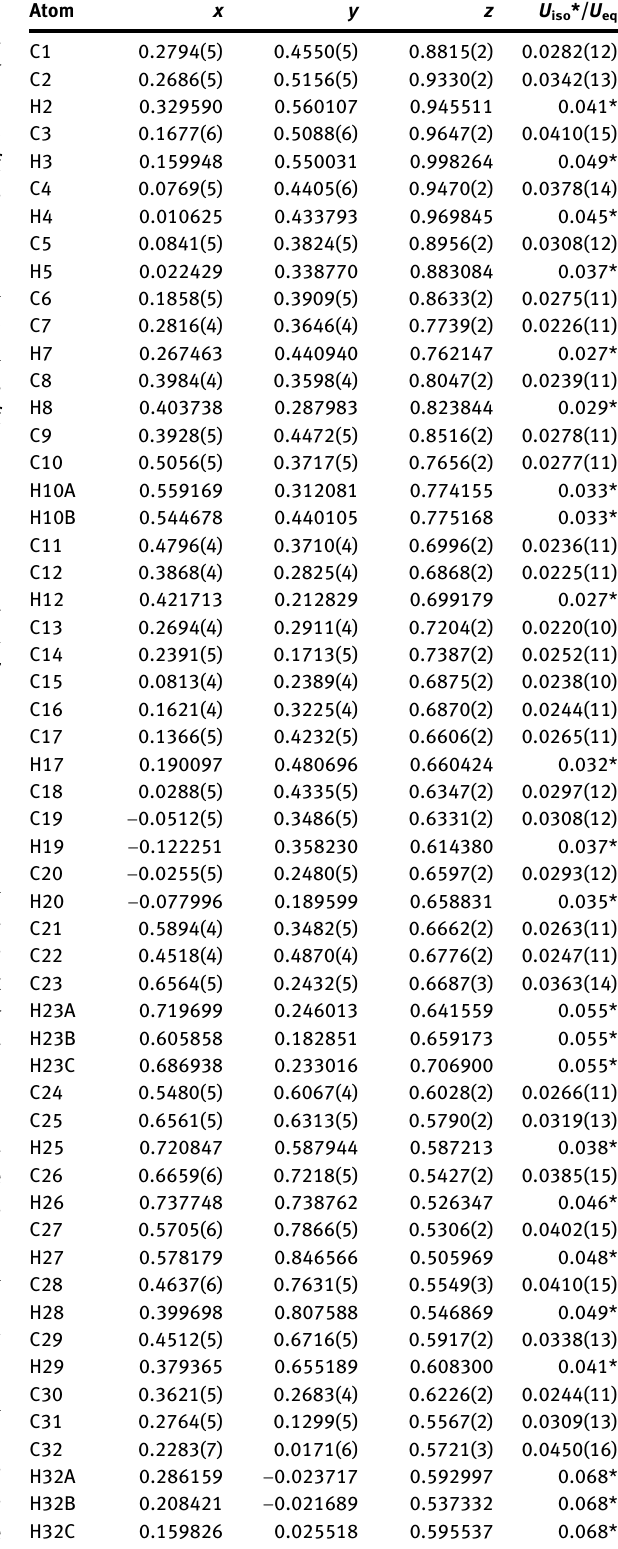
Table  : Fractional atomic coordinates and isotropic or equivalent isotropic displacement parameters (Å 